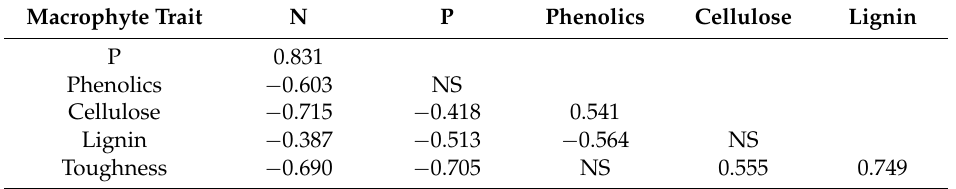
Table 3. Pearson’s correlation coefficients between the macrophyte traits of the five study species.